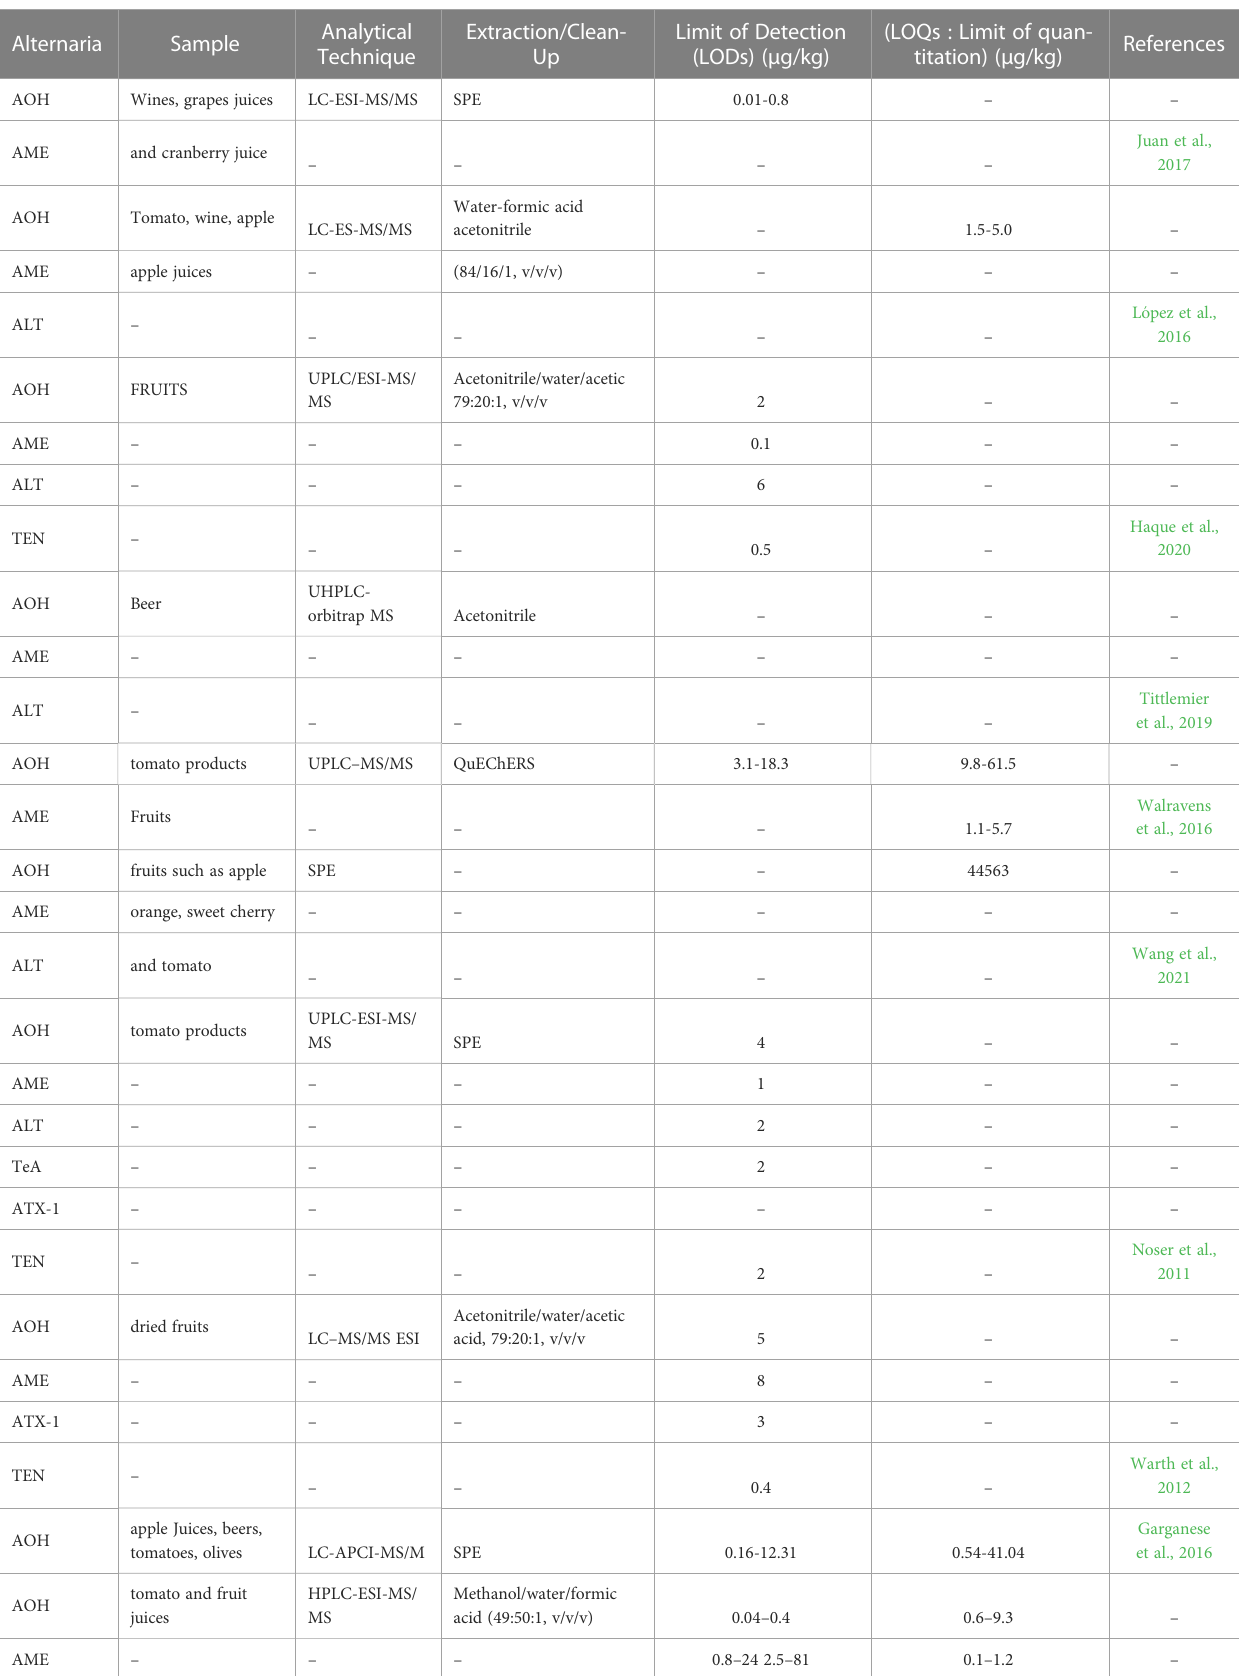
TABLE 5 Alternaria mycotoxin detection using LC –